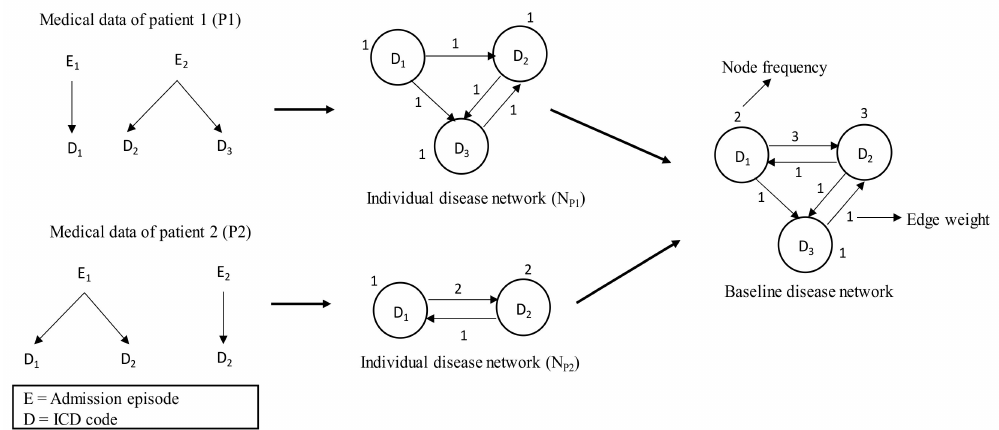
Figure 1. Construction of baseline disease network. First, individual disease networks are developed from medical data of the corresponding patients and are then aggregated to generate the baseline disease